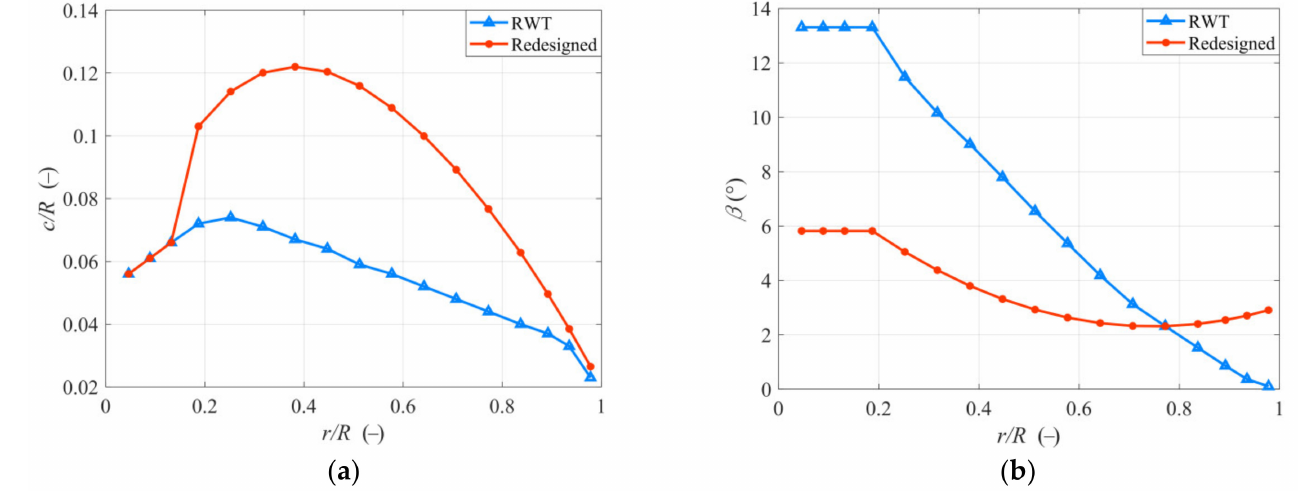
Figure 6. Comparison of the redesigned blade and the RWT blade. ( a ) Chord. ( b ) Twist.